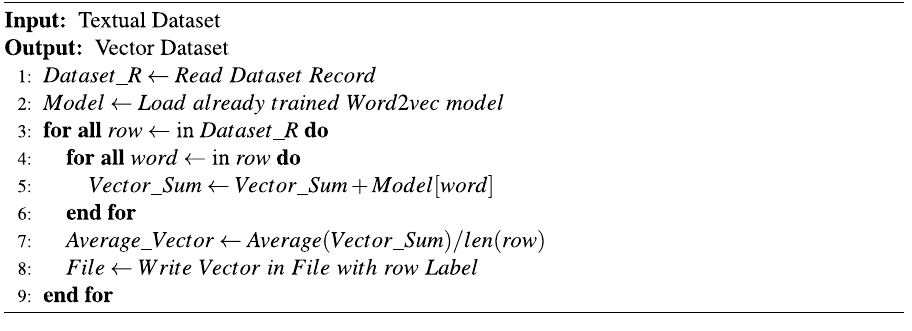
Figure 4. Conversion of text into vector.